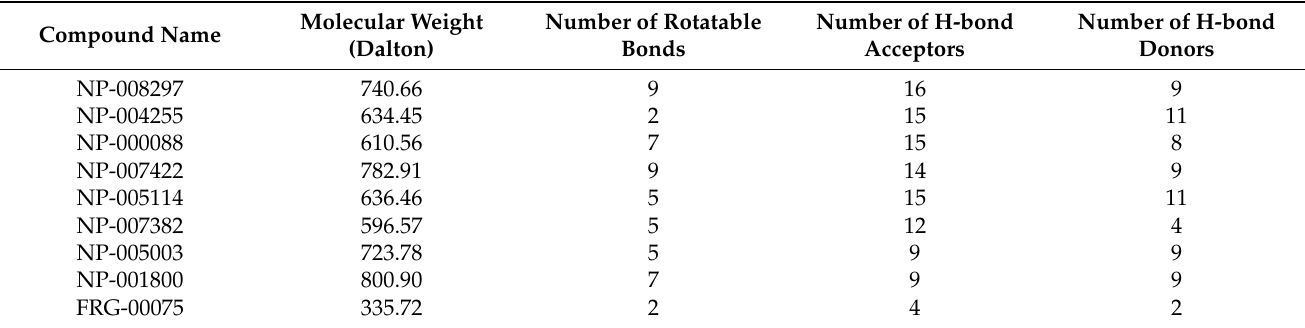
Table 5. Physicochemical properties of the 9 selected compounds.